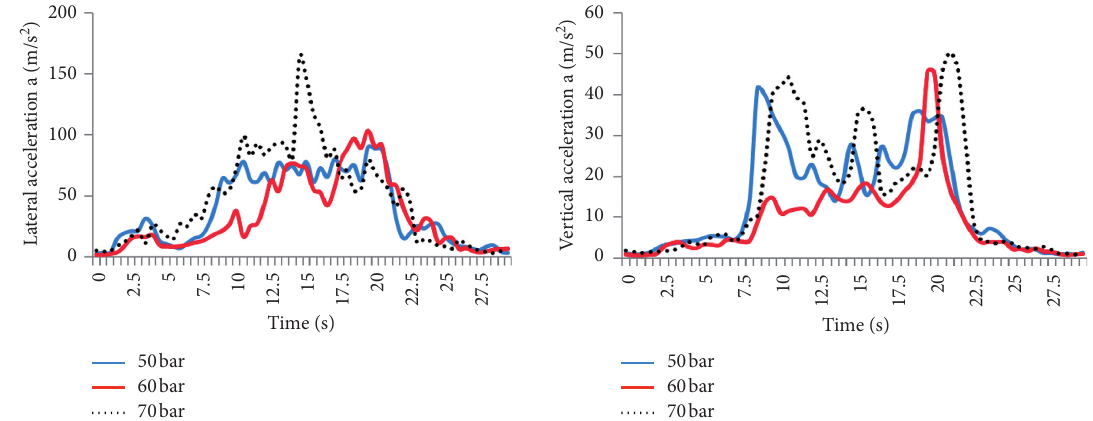
Figure 11: The envelope of acceleration of sleeper under different